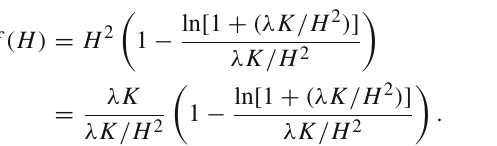
and λ is a non-negative constant, i.e., λ ≥ 0. The accelera- tion equation given by Eq. (35) can be derived from the holo- graphic equipartition law with the modified Rényi